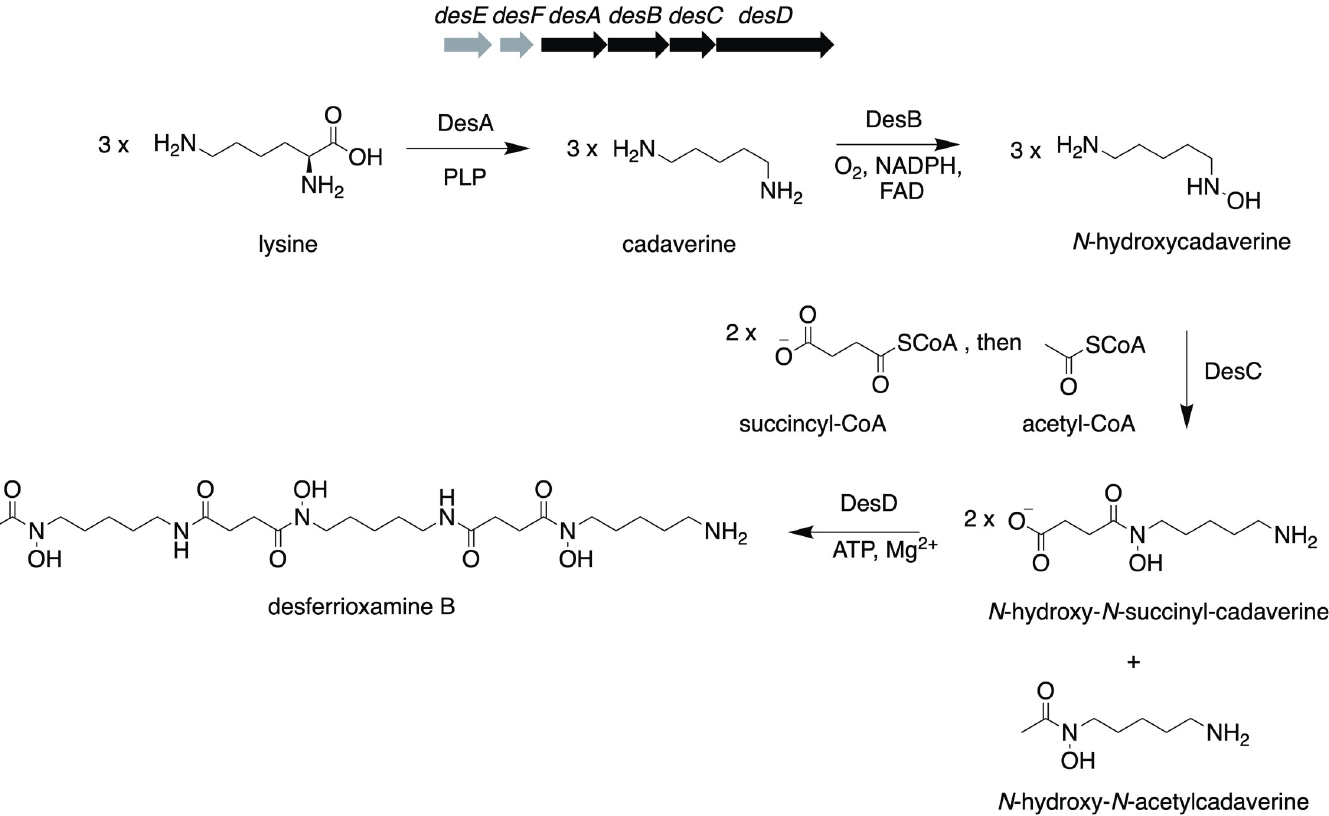
Fig 1. Desferrioxamine B biosynthetic pathway in S . sviceus . Organization of the biosynthetic gene cluster in S . sviceus and proposed enzymatic steps involved in the synthesis of desferrioxamine B. Genes encoding the four desferrioxamine biosynthetic enzymes are in black ( desA , desB , desC , and desD ) and genes involved in ferrioxamine uptake and utilization are in grey ( desE and desF